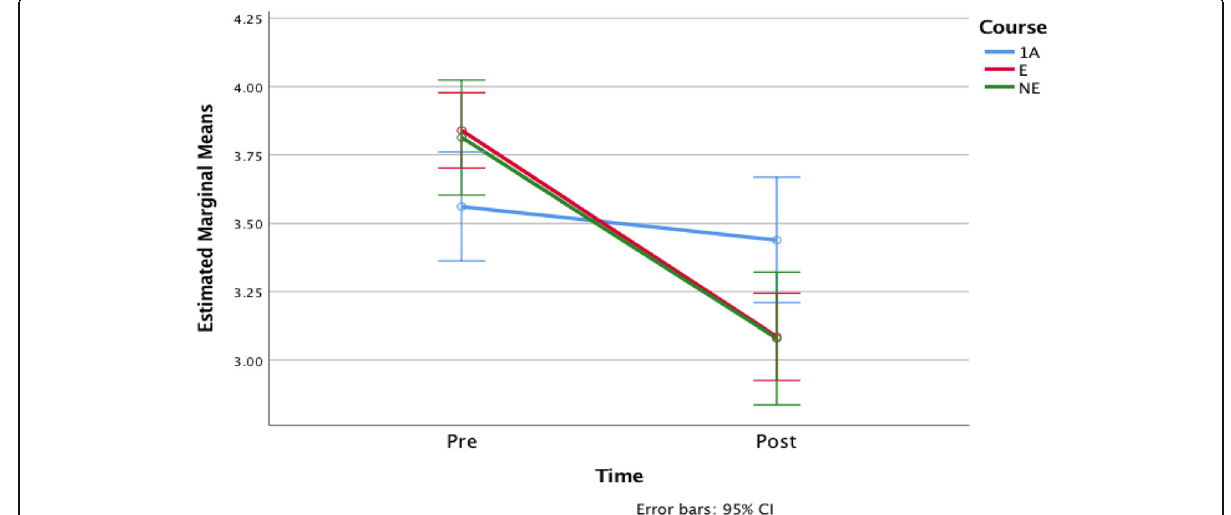
Fig. 2 Estimated marginal means of